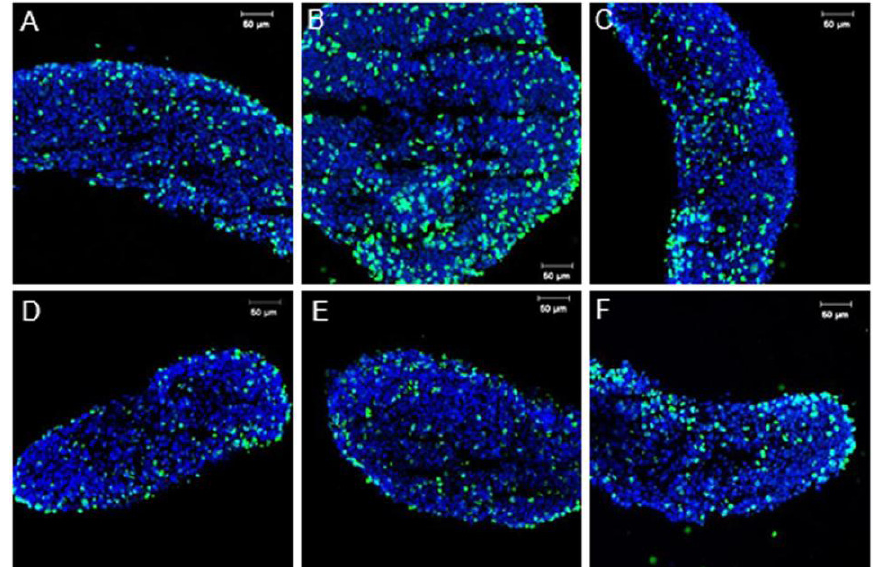
Figure 3. Immunofluorescence of BrdU in experimental controls ( A ) CO, ( B ) CL, ( C ) CS; and ( D (cid:177) F ) gonads transfected with 100, 300 and 600 pmol of siRNA, respectively. Scale bar = 20